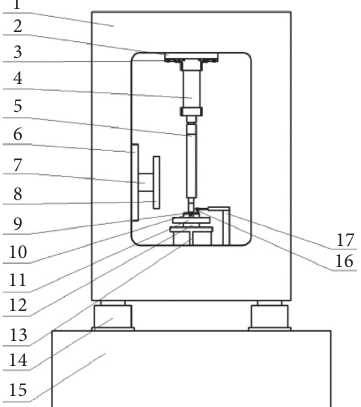
Figure 16: Schematic diagram of the overall structure of the test platform. (1) Mouth-shaped granite frame; (2) cylinder base; (3) bolt; (4) loading cylinder; (5) static force applying rod; (6) bracket; (7) connecting frame; (8) connecting plate; (9) steel ball; (10) tested aerostatic bearing; (11) pressure test plate; (12) force sensor; (13) bearing platform; (14) vibration isolator; (15) granite base; (16) displacement sensor; and (17) support bracket.